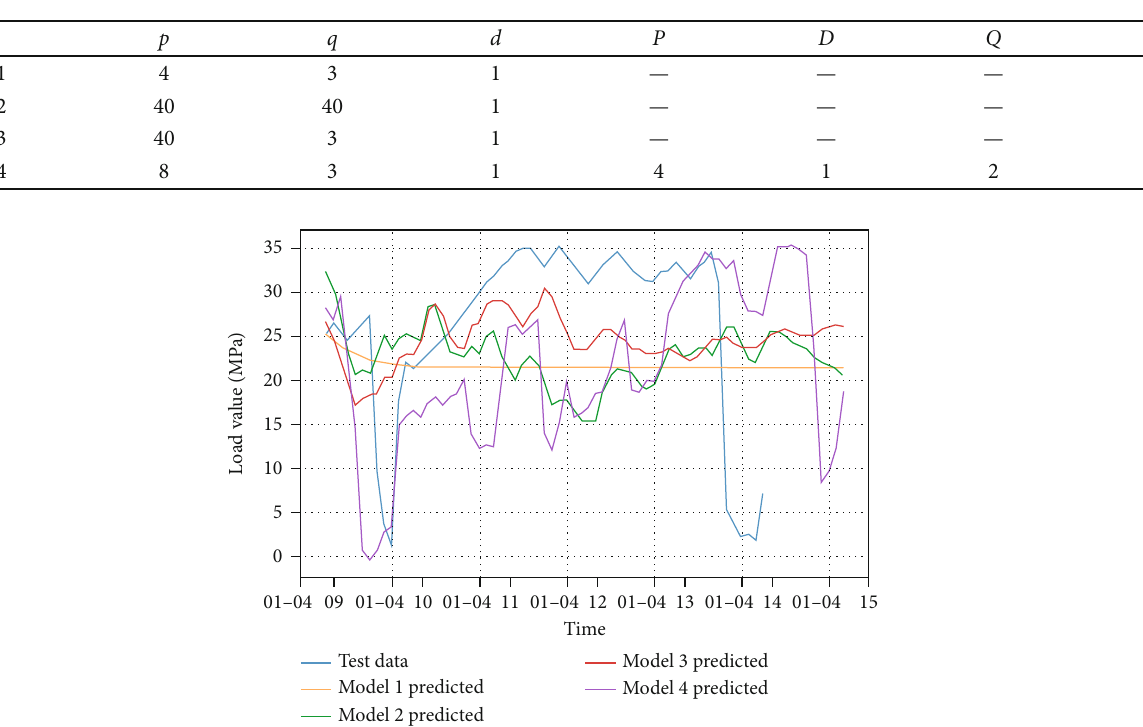
Table 3: Parameters for the four models.